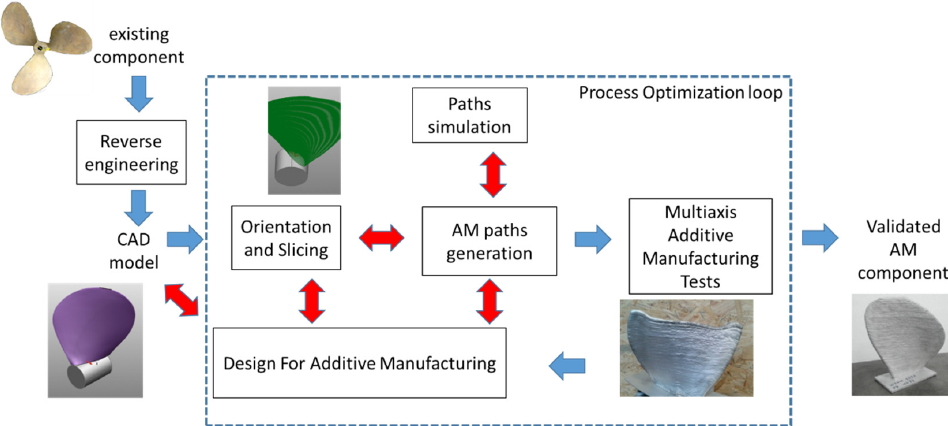
Figure 11. Numerical data chain for the propeller use case.